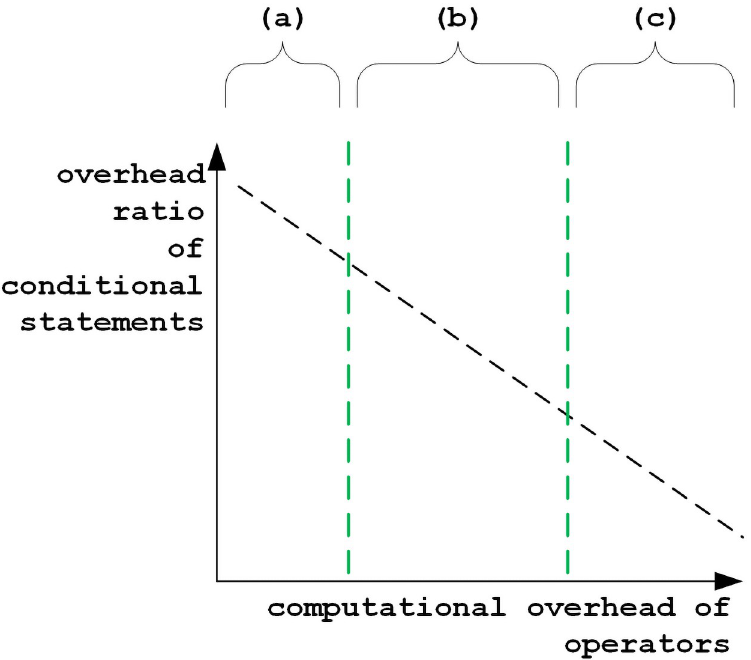
Fig 3. Overhead ratios of conditional statements according to computational overhead for performing